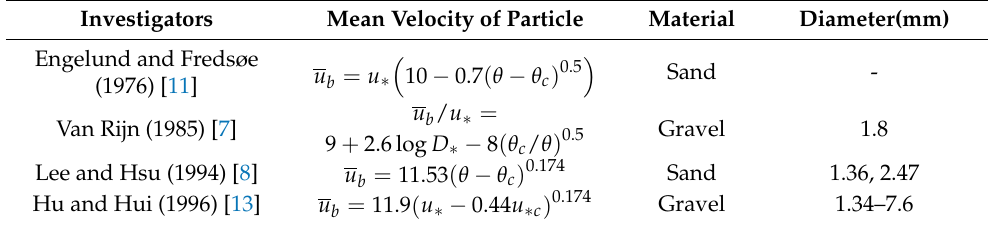
Figure 17. Frequency distributions of dimensionless velocity of sediment particles. The formulas of mean velocity of a saltating particle are proposed by the different investigators based on experimental data, as can be seen in Table 3. Figure 18 presents a comparison of the dimensionless streamwise saltation velocity between the present simulated results and the empirical formula [7,8,11,13]. It is found that the predicted results of the empirical formula are quite scattered, except for the empirical formula [7,8]. In this study, the present simulated results of the SRP and SP are presented in order to analyze the distinction of different movement modes. Figure 18 indicates that the present simulated results of the SRP are lower than the predicted results of the empirical formula, and the present simulated results of the SP are between the curves of the empirical formula. For the SRP, the sediment particles move near the sediment bed and contact with the bed frequently, so the bed resistance decreases the streamwise velocity of the SRP. For the SP, the collisions between sediment particles under the strong turbulence structure increase the flight time, and cause saltation particles to absorb more energy from the flow and increase sediment particle velocity. The other possible reason for the difference between the present simulated results and the predicted results of the empirical formula is the shape and size of particles. The smooth particles move with the lower and shorter jumps more than the rough particles of the same mean diameter, and are less influenced by the flow velocity than the coarse particles; therefore, the velocities of smooth particles are less than those of the rough particles [68]. Table 3. Formulas of mean velocity u b of saltating particles given by different investigators. Investigators Mean Velocity of Particle Material Diameter(mm) Engelund and